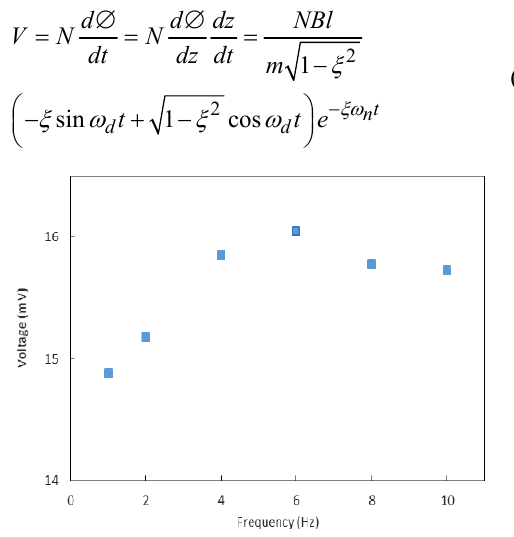
Figure 10. Analytical output voltage at different applied